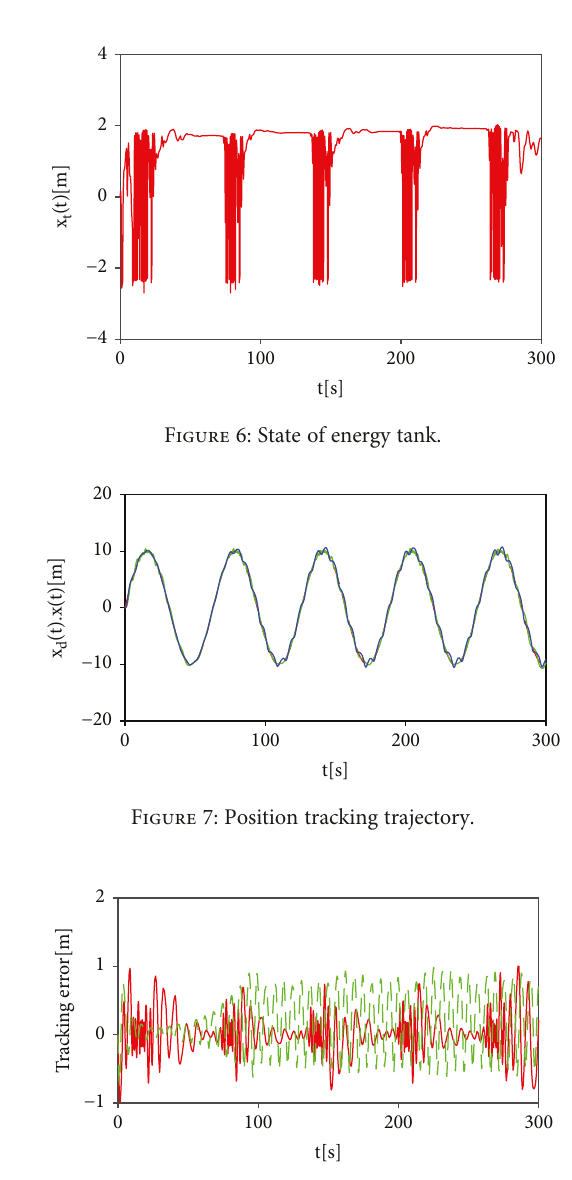
Figure 8: Tracking error